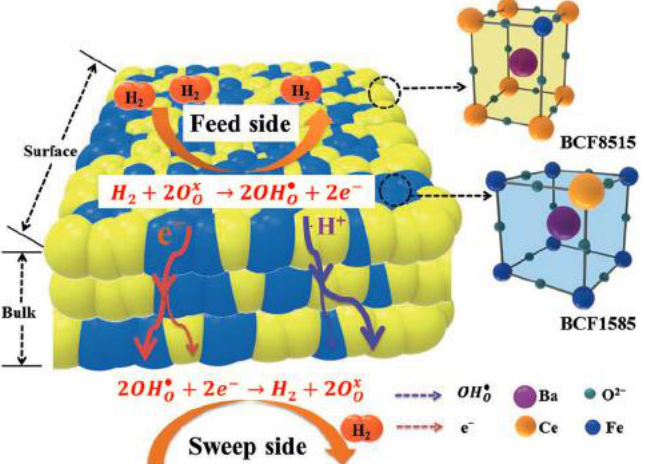
Figure 10. BaCe 0.5 Fe 0.5 O 3- δ -based dual-phase membrane prepared by automatic phase separation technique [71].